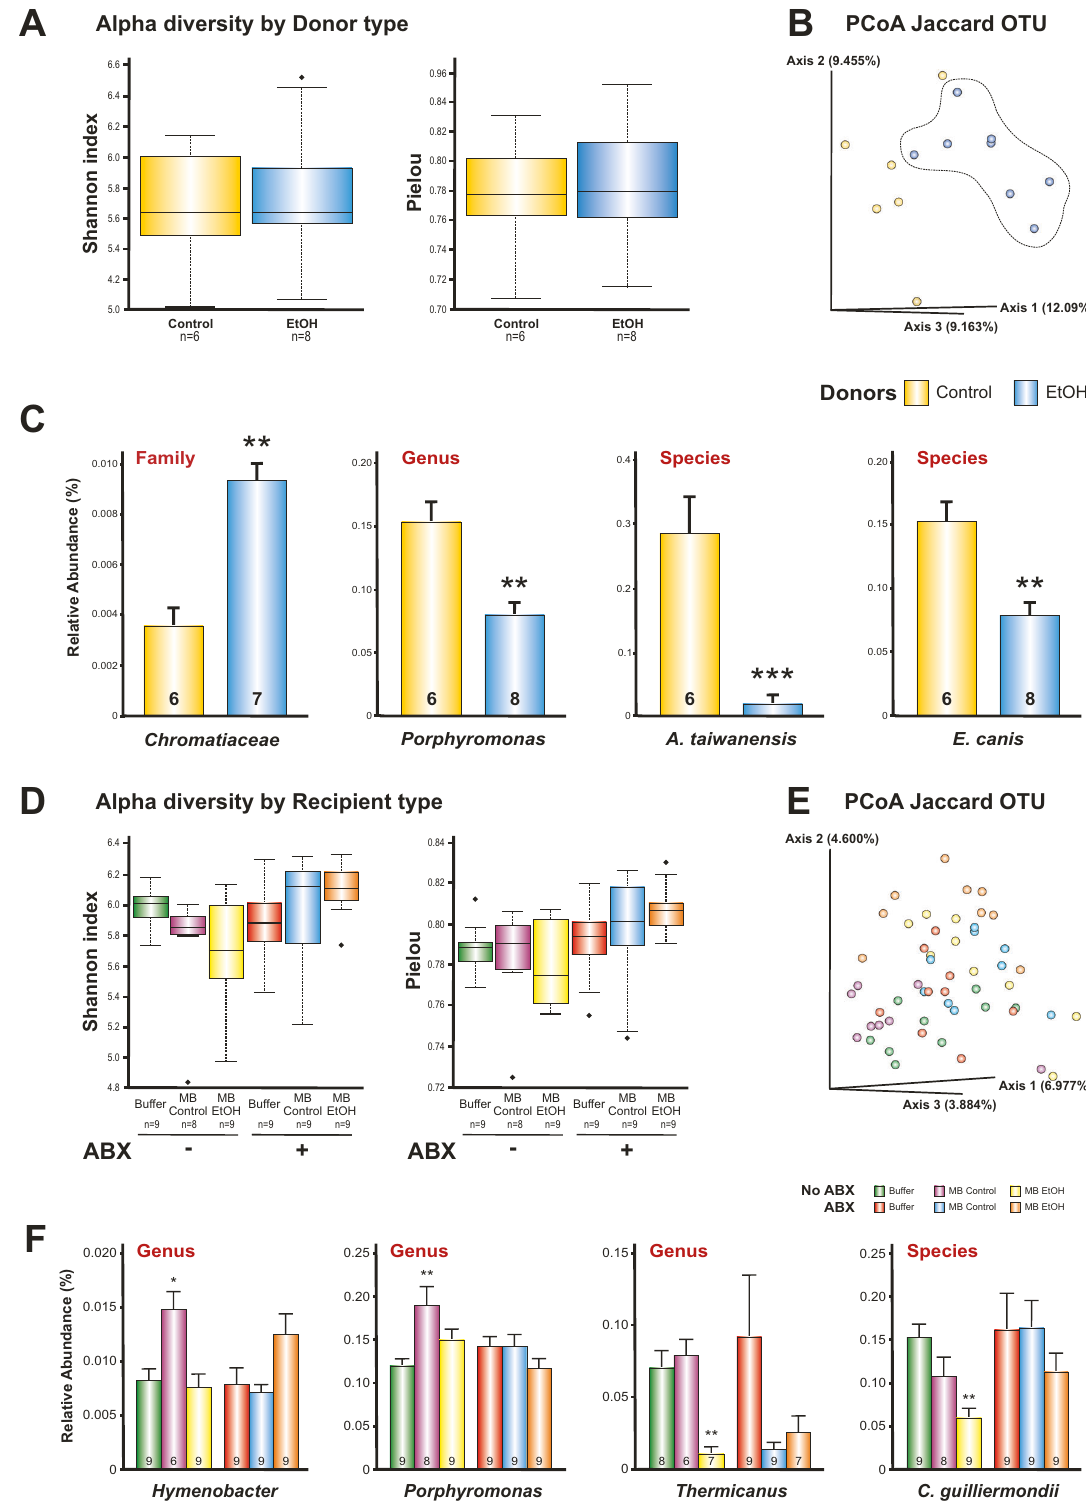
Fig. 5 IMB composition in donor and recipient animals. Between alcohol- and control-donor groups there were not signi fi cant differences in Alpha diversity ( A ) but in Beta diversity (Jaccard distance index, p < 0.001) ( B ). Signi fi cant differences in relative abundance of bacteria between alcohol- and control-donor groups are shown in C (** p < 0.01; *** p < 0.001 compared to Control Group). Alpha diversity was not signi fi cant ( p = 0.09) between recipient groups ( D ) but it was in Beta diversity ( p < 0.001) ( E ). Relative abundance of bacteria in recipient groups are shown in F . * p < 0.05; ** p < 0.01 compared to the respective Buffer groups, within each category (ABX, No ABX); C , F graph represent mean ± s.e.m. Source data are provided as a Source Data fi